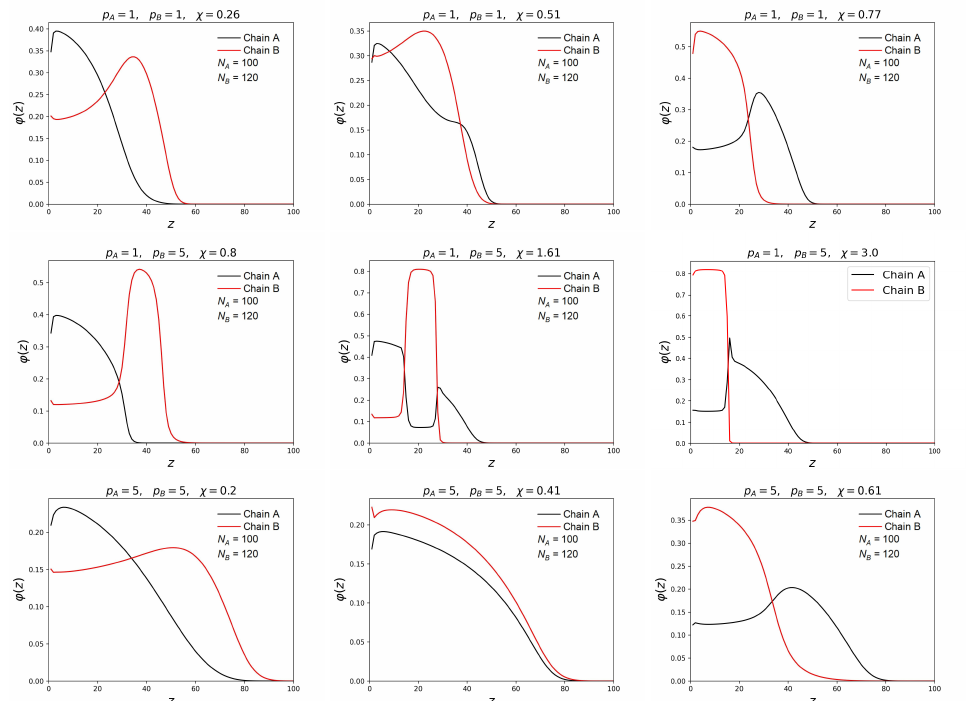
Figure 2. Volume fraction profiles of the monomer units of chains in the brush at the grafting density σ = 0.1. Profiles for non-responsible chains are denoted in black, and responsible ones are denoted in red. The distributions in the middle column correspond to the segregation transition point χ = χ ∗ . In neighboring columns, the solvent selectivity differ towards the smaller and the higher values,